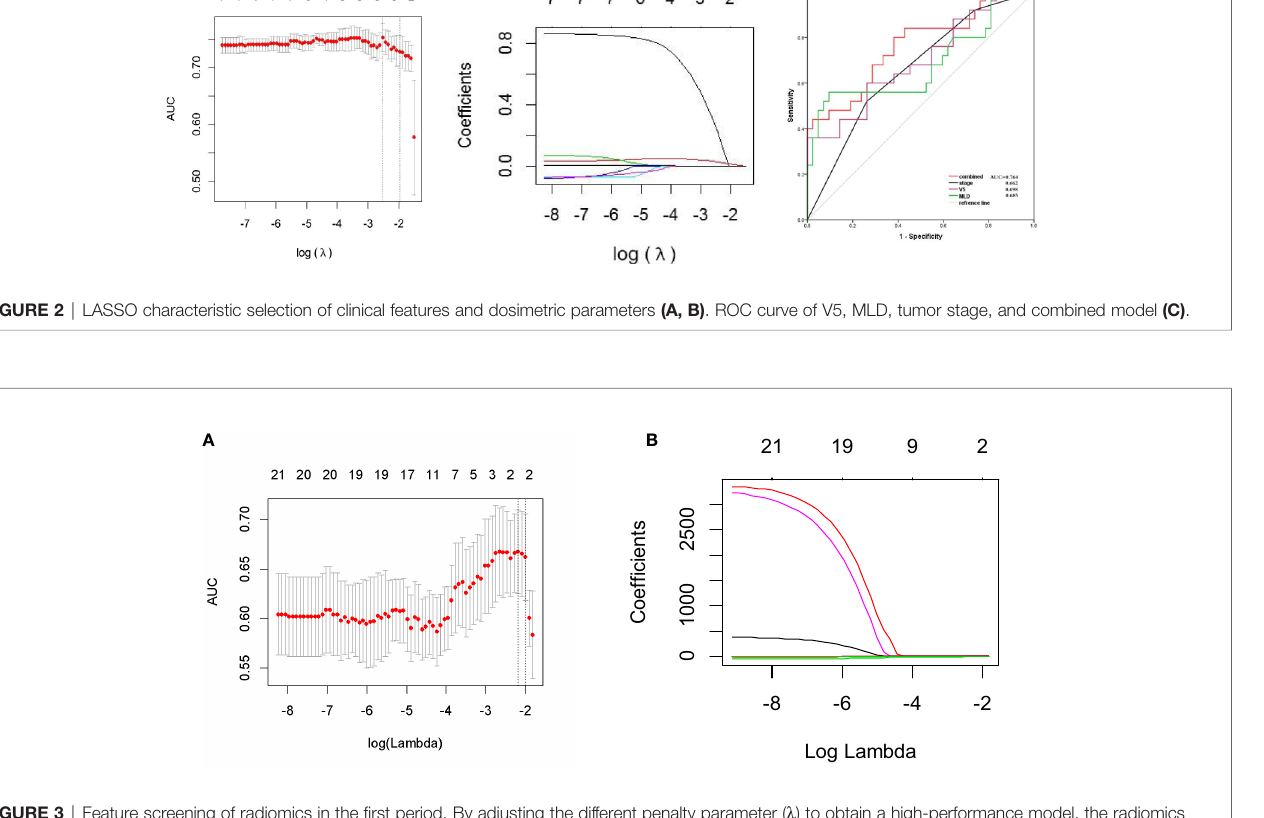
FIGURE 3 | Feature screening of radiomics in the fi rst period. By adjusting the different penalty parameter ( l ) to obtain a high-performance model, the radiomics characteristics with the highest predictive performance were obtained. Radiomics feature convergence diagram (A) . Each curve represents the trajectory of the coef fi cient of each independent variable (B)